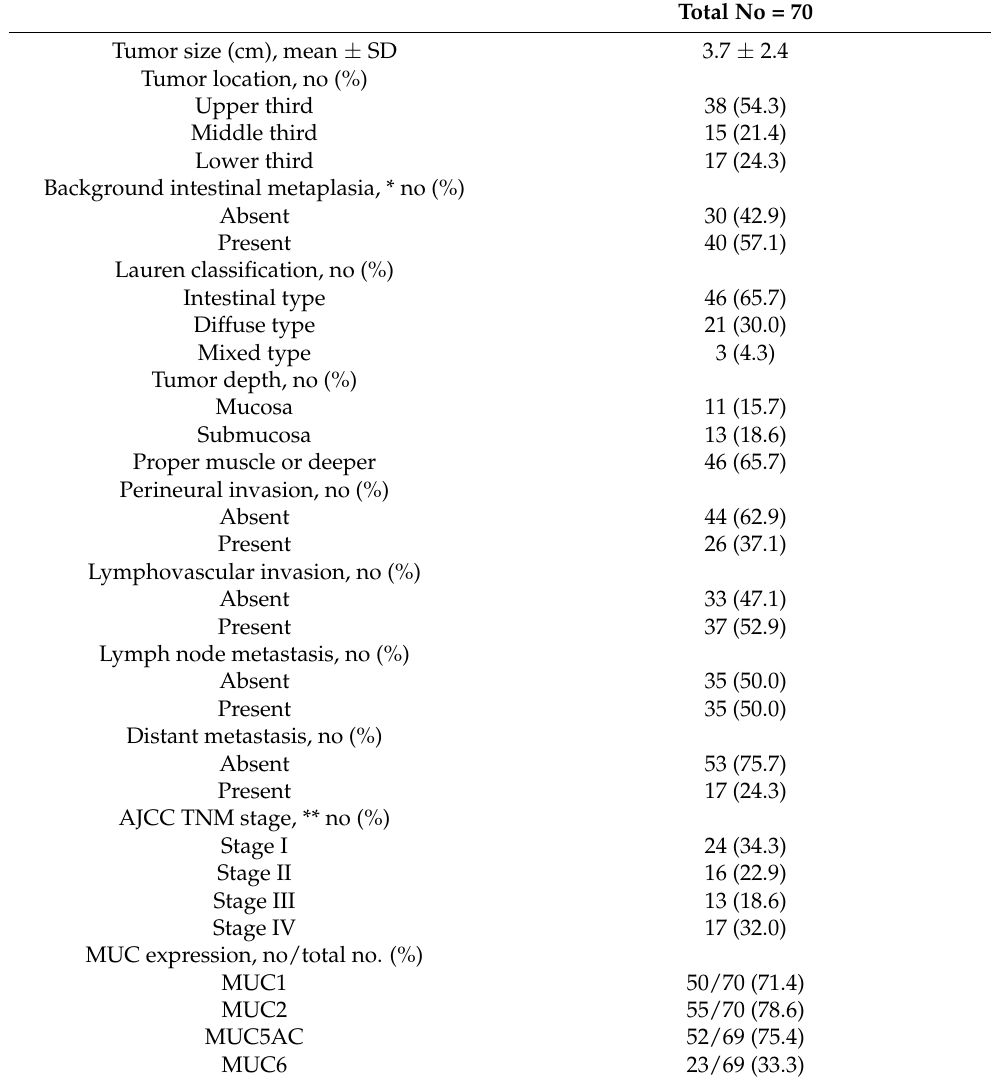
Table 2. Tumor characteristics and mucin